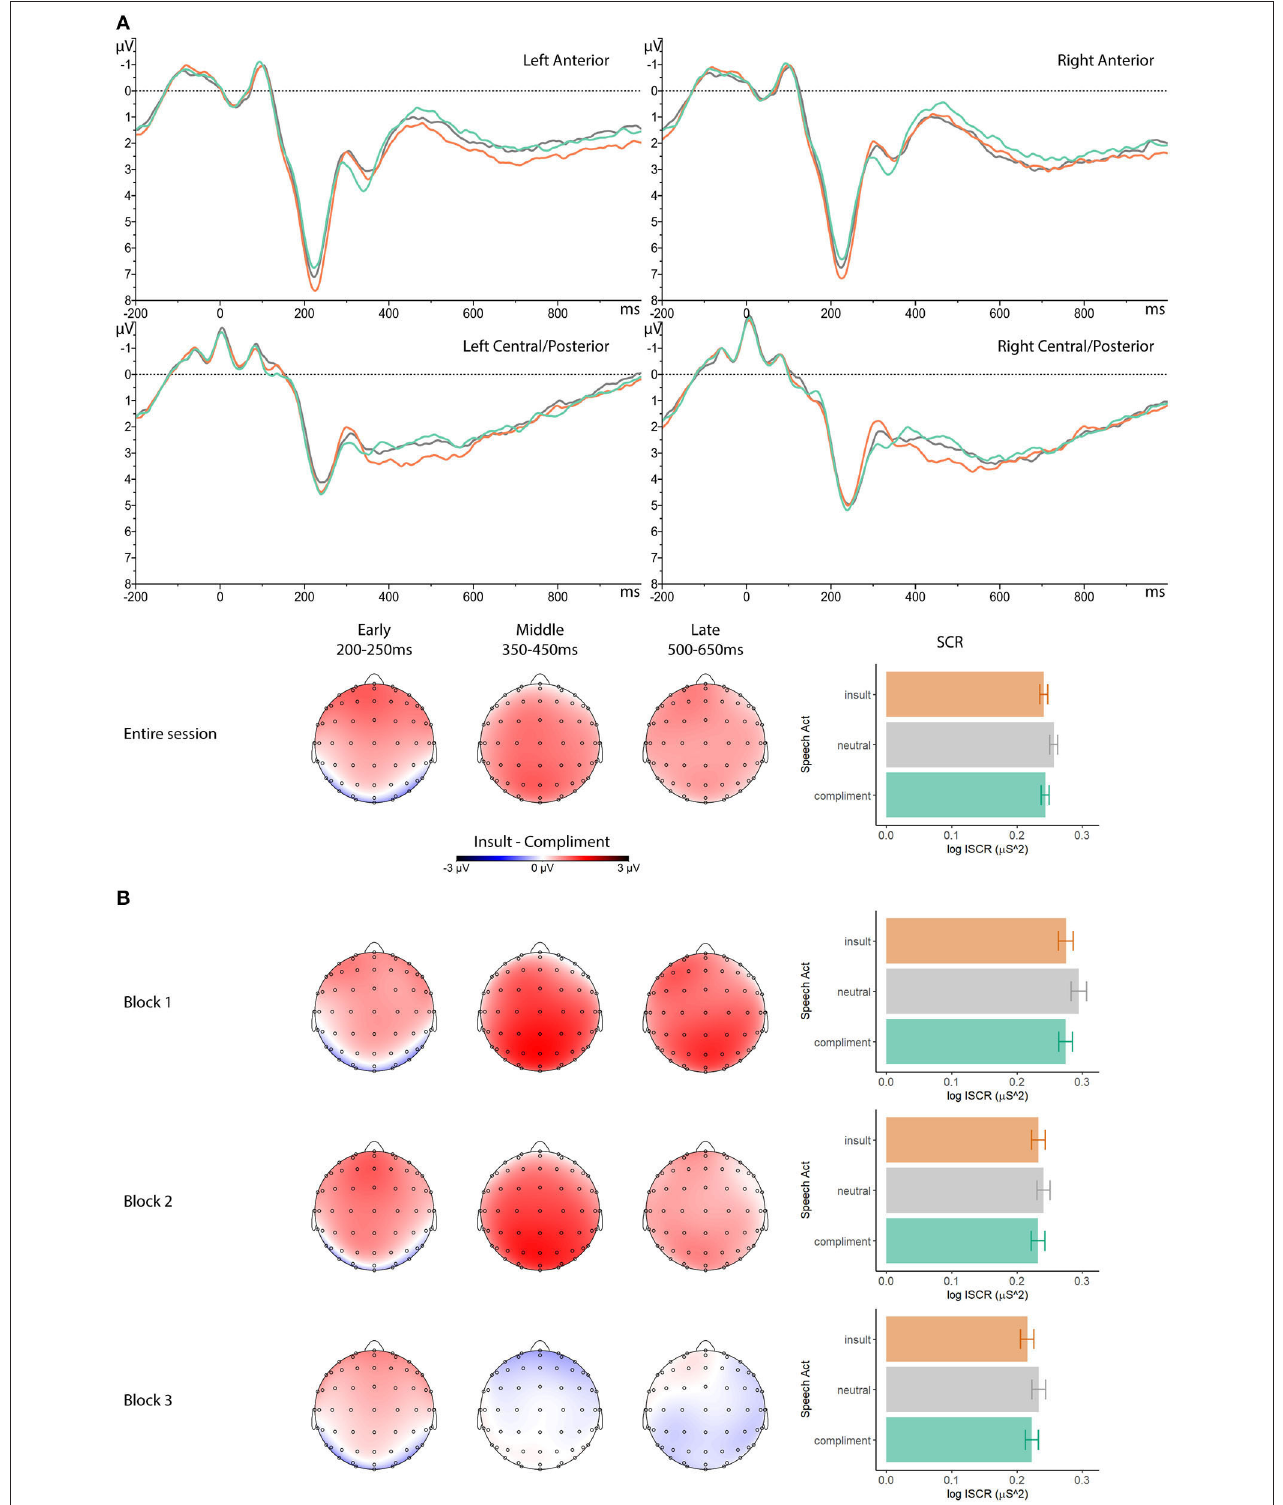
FIGURE 2 | Observed effects of speech act type across the whole session and as a function of block. (A) Grand average ERP waveforms ( µ V, negative up) in four scalp regions for insults, compliments and neutral descriptions, scalp distribution of the insults minus compliments differential ERP effect in three latency ranges of interest ( µ V, three left topographical maps), and the grand average event-related whole-trial skin conductance response (log ISCR 2 , right bar graphs) for insults, compliments and neutral descriptions, all across the entire session. (B) Identically scaled ERP effect scalp distributions and average event-related whole-trial skin conductance response for each of the three relevant blocks in the